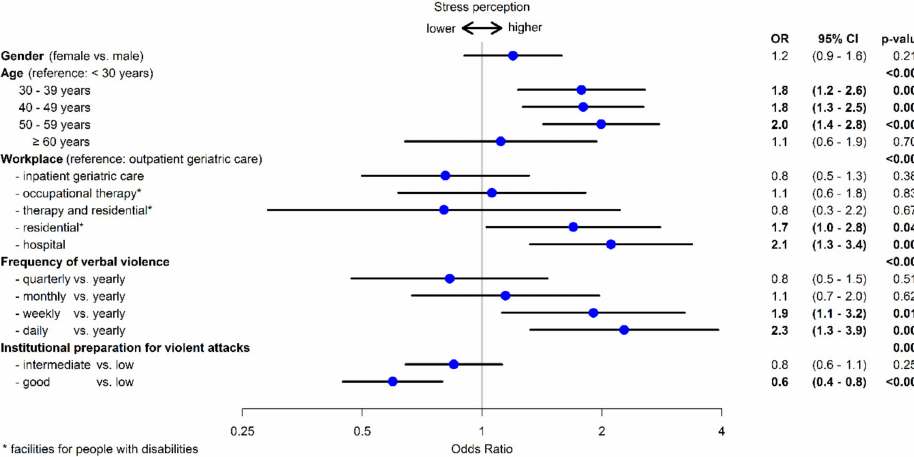
Figure 3. Risk factors for high stress perception ( n =